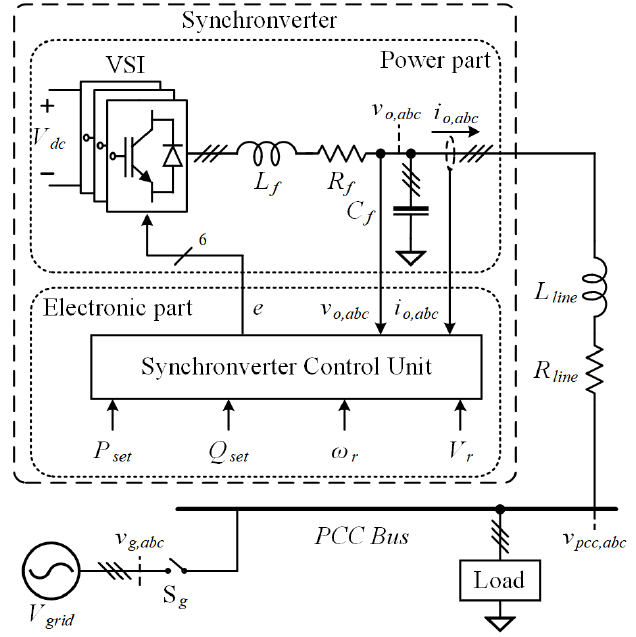
Figure 1. Block diagram of synchronverter